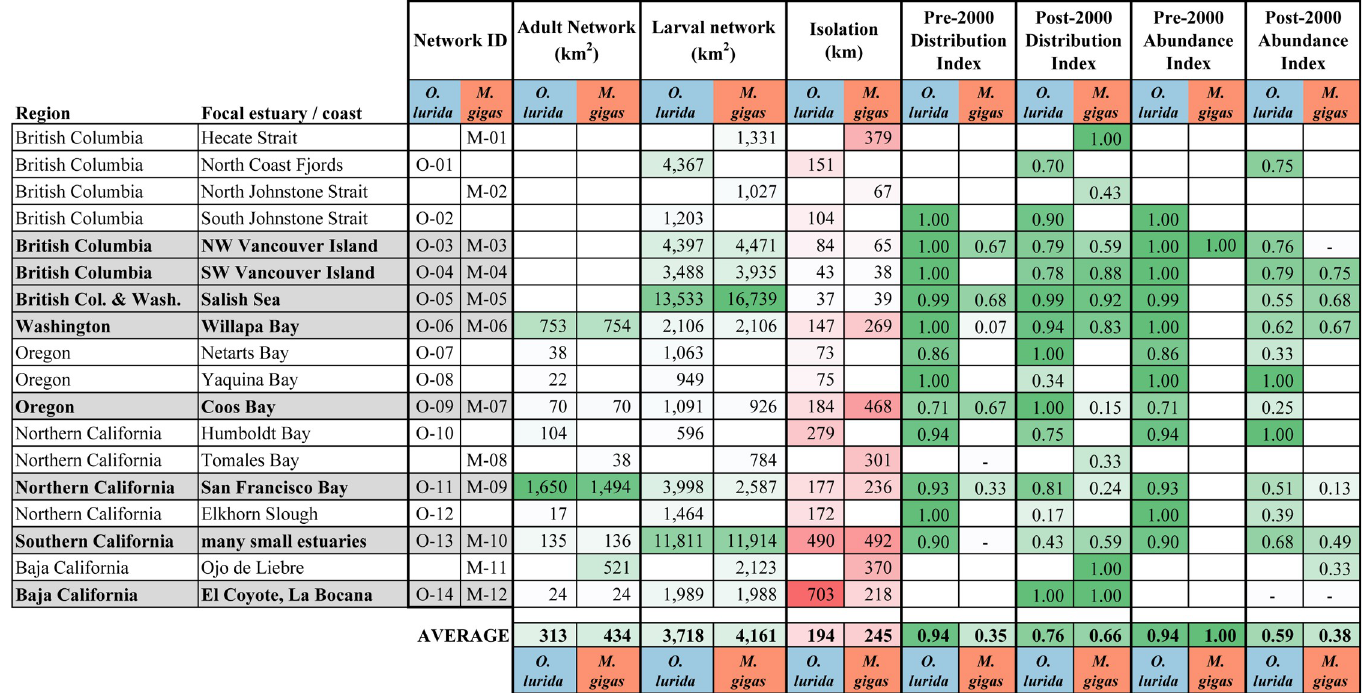
Fig 9. Summary of oyster network data. Networks are listed from north to south. In the eight rows with bold font and gray shading, the networks for both oyster species share the same focal estuary, and can be directly compared. Adult network size could not be calculated for the northern estuaries since no geospatial layer of estuarine boundaries was available. Conditional formatting was applied, in green to parameters that are favorable to oyster population persistence (large networks, high abundance, etc .) and in red for network isolation, where high numbers indicate long distances to the next adjacent network, which is unfavorable to among-network population connectivity.